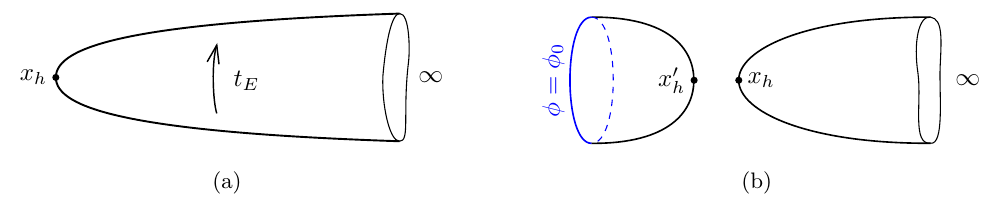
Figure 7 . Geometries for Euclidean calculations of the black hole